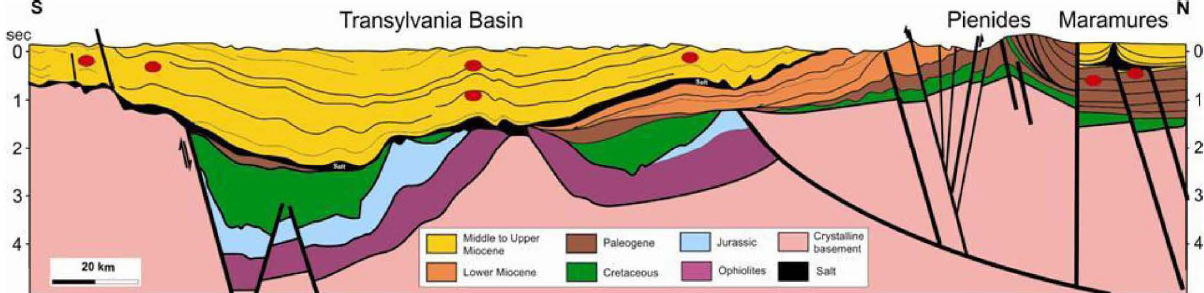
Figure 3. North–South Geological cross-section through Transylvanian Basin [11].